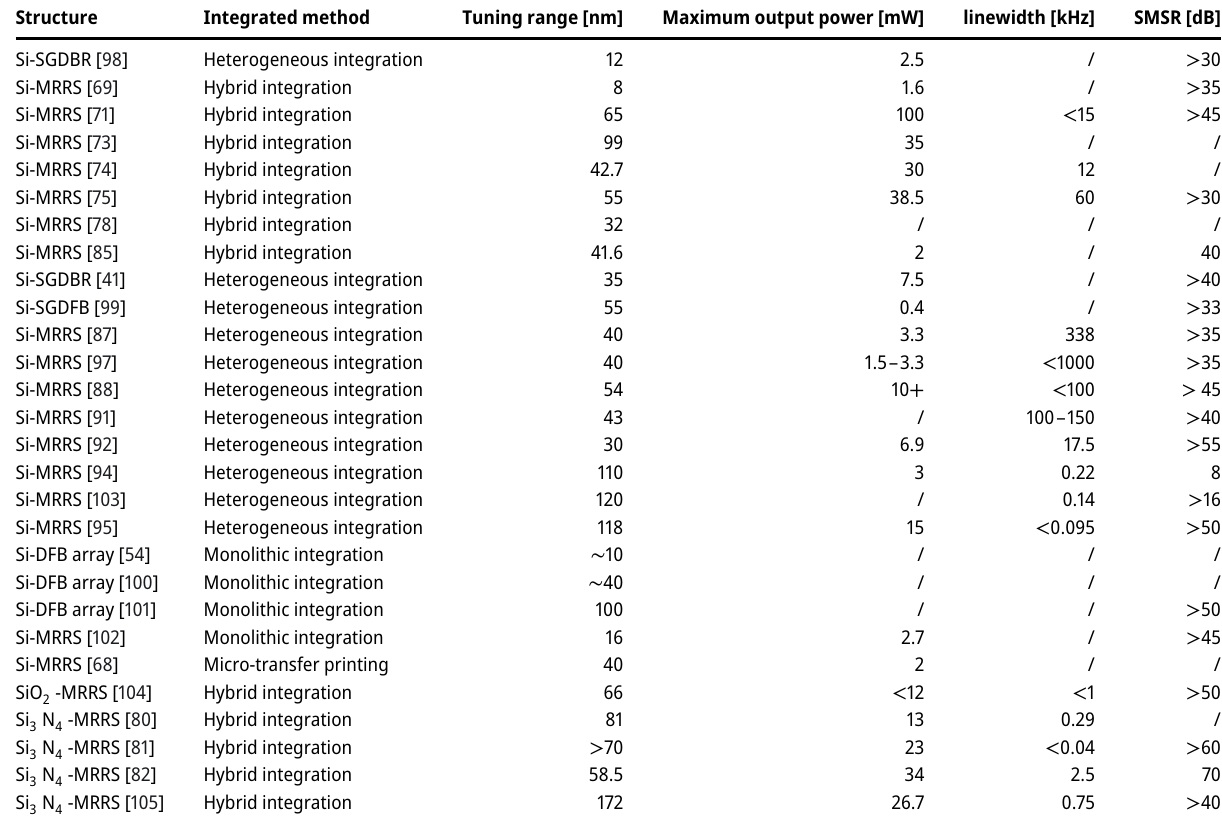
Table 2: Performance comparison of tunable semiconductor lasers.